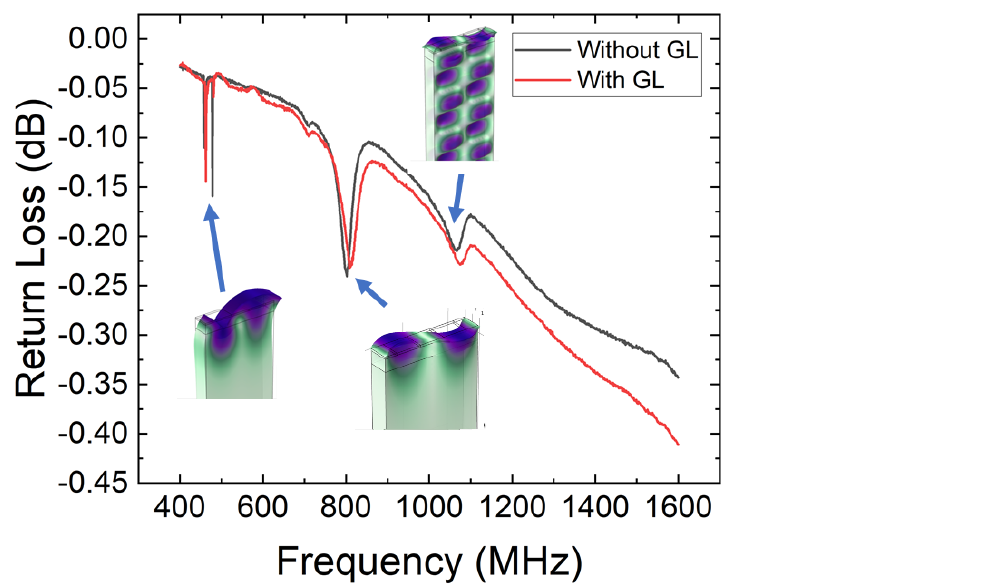
Figure 6. Return loss measurement at room temperature versus frequency under the conditions of without and with a guiding layer for W = 2.5 µm. R, S, and PB denote Rayleigh, Sezawa, and pseudo-bulk,